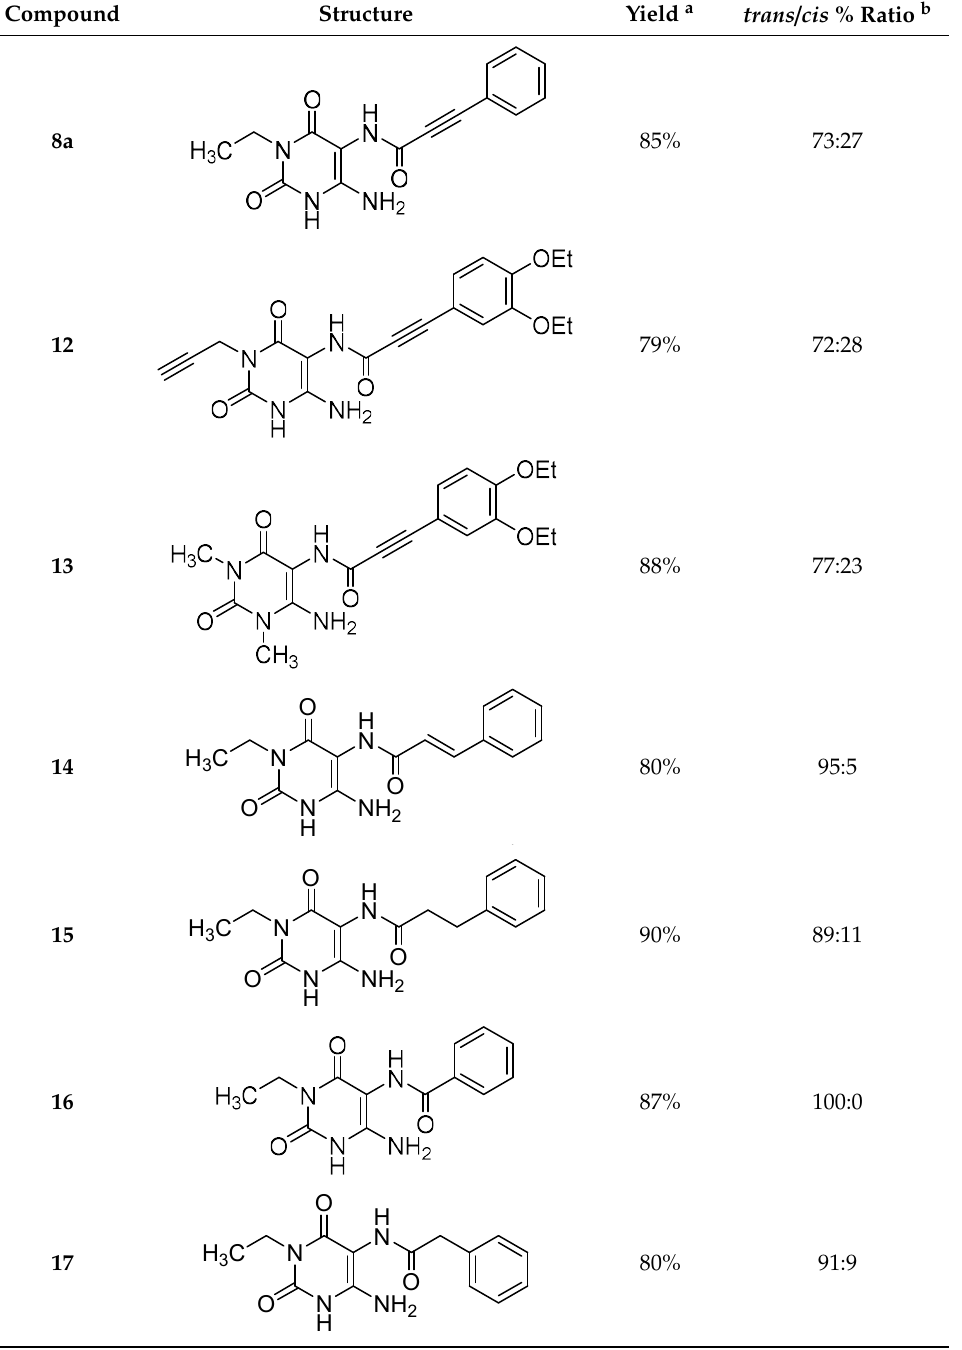
Table 1. Synthesized 6-amino-5-carboxamidouracil derivatives, yields, and experimental trans / cis ratios from 1 H-NMR in DMSO- d 6 .